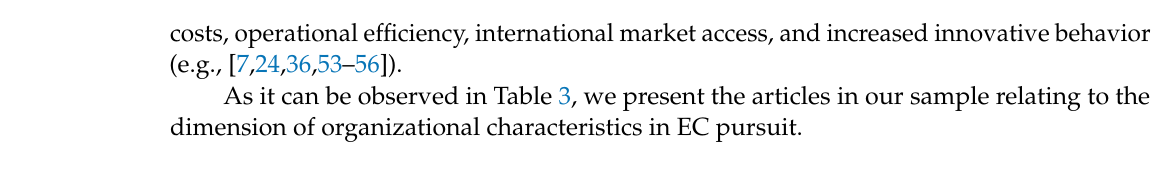
Table 3. Articles regarding the dimension of organizational characteristics in EC